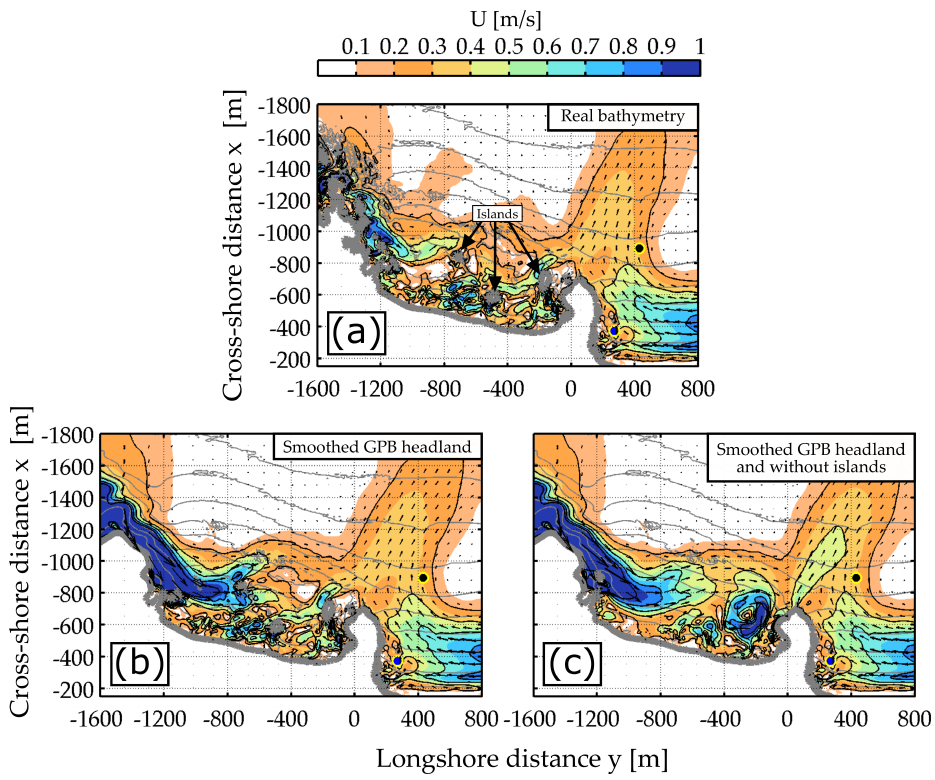
Figure A1. Modelled velocity fields along the adjacent embayment for three idealised bathymetries: real bathymetry ( a ), smoother GBP headland ( b ) and removing the GPB islands ( c